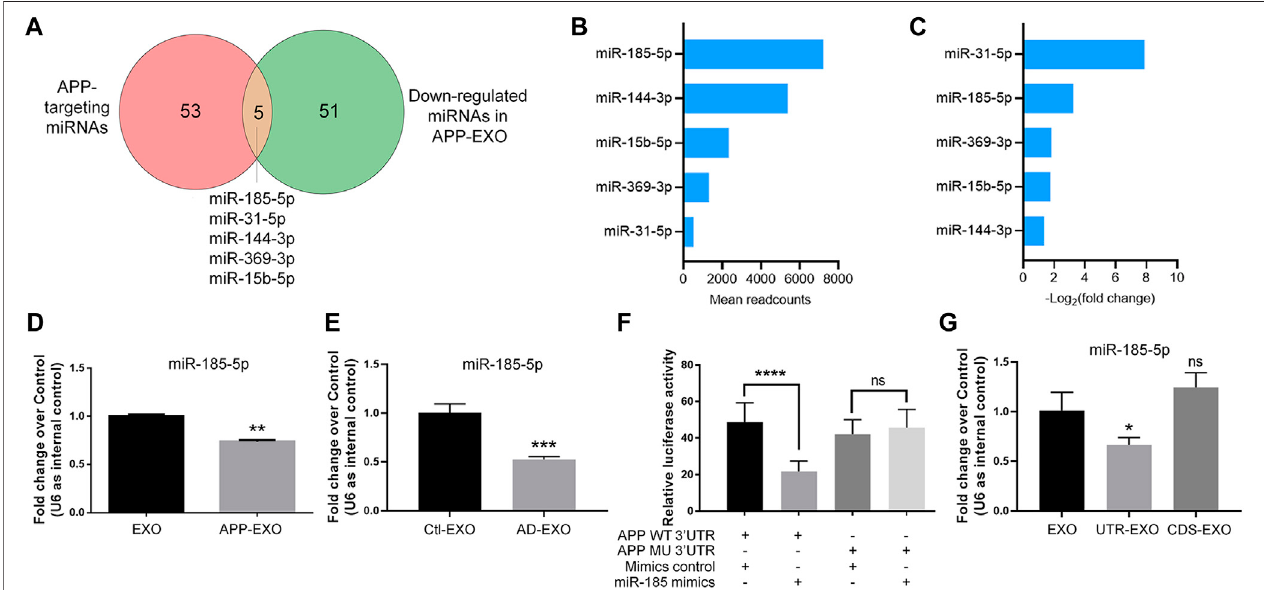
FIGURE 5 | APP overexpression inhibits miR-185-5p sorting to exosomes via the direct interaction between APP 3 ′ UTR and miR-185-5p. (A) The numbers of APP-targeting miRNAs and down-regulated miRNAs in APP-EXO were shown in the Venn diagram. The overlapping miRNAs were listed. (B) The readcounts of fi ve overlapping miRNAs in EXO were ranked from more to less. (C) The fold changes of fi ve overlapping miRNAs between APP-EXO and EXO were ranked from more to less. (D) The down-regulation of miR-185-5p in APP-EXO was determined by RT-qPCR. (E) The down-regulation of miR-185-5p in AD-EXO was determined by RT-qPCR. (F) Repression of luciferase activities by the APP 3 ′ UTR were dependent on miR-185-5p. Fire fl y luciferase activities were normalized to the internal control, Renillaluciferaseactivities. (G) Thedown-regulationofmiR-185-5pinUTR-EXO,butnotCDS-EXO,wascon fi rmedbyRT-qPCR.Datawererepresentedasmean±s.d. from three independent experiments. *, **, ***, and **** denote p < 0.05, p < 0.01, p < 0.001, and p < 0.0001, respectively. ns denotes no signi fi cance.